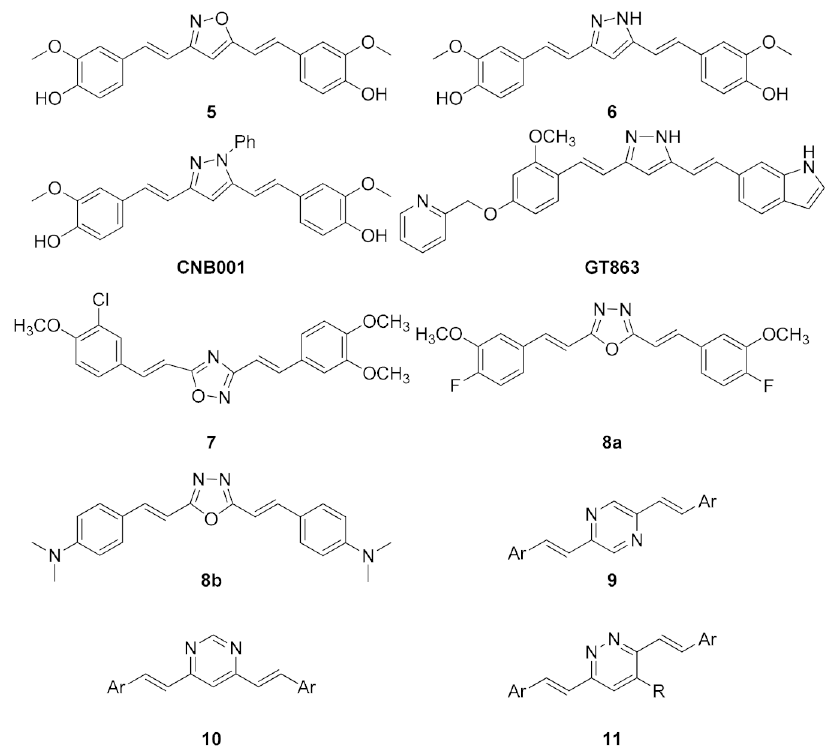
Figure 3. Structures of heterocyclic